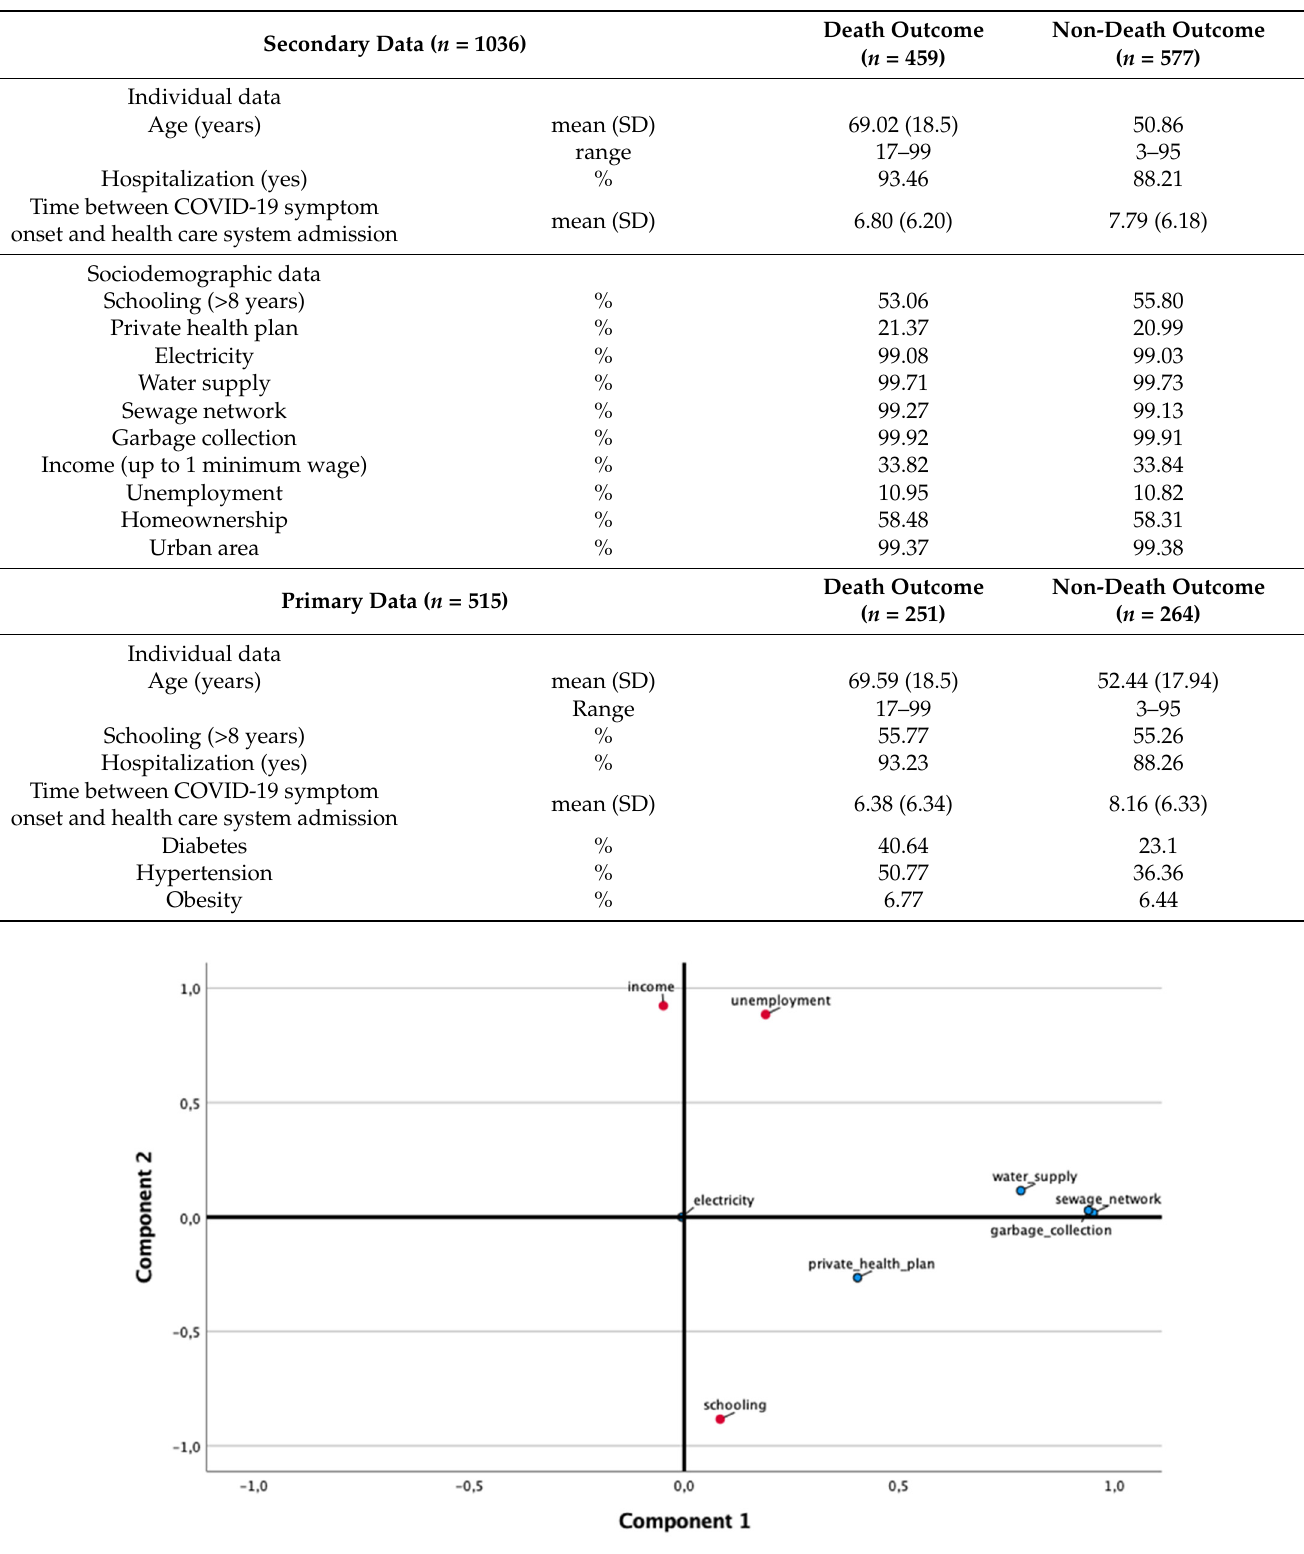
Table 1. Demographic and clinical characteristics of a convenience sample of COVID-19 confirmed individuals who sought treatment at the emergency units of the public health system of Diadema (Brazil) from March to October 2020, according to outcome.